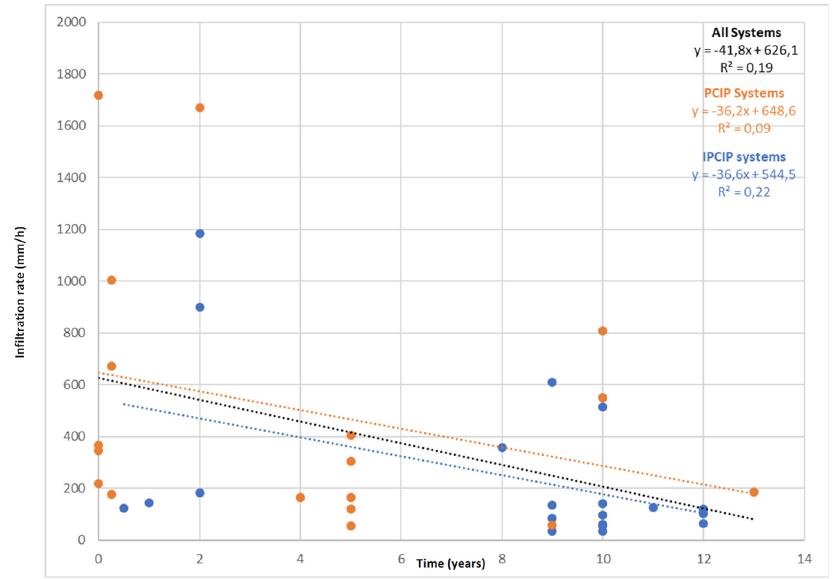
Figure 5. Linear trend lines indicating the decay in infiltration capacity of all (black), PCIP (orange), and IPCIP (blue) systems over time. The given equations and R 2 of the linear trend lines indicate the decay in infiltration rate in mm/h per year and the explanatory power of time/age (goodness-of-fit) to the yearly decay in infiltration rate. The low values of R 2 indicate that the predictive value of the equation is not strong. Table 1. Application of the observed time effects on the infiltration rate of infiltrating pavements in relation to the national guidelines and international standards and percentage of systems (%) functioning according to (inter)national standards in years after the moment of